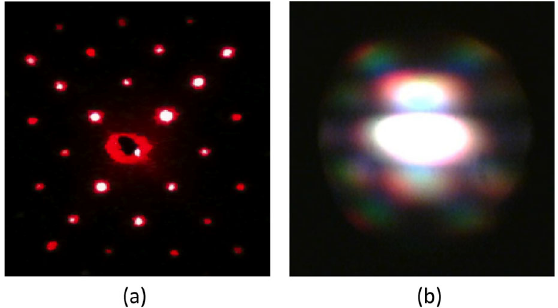
FIG. 4. (a) Single wavelength diffraction pattern; and (b) white light diffraction pattern, both formed from a 45 (cid:5) rotated DMD with all pixels set at þ 12 (cid:5) .